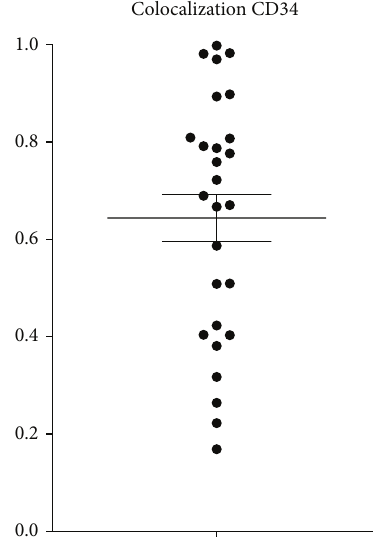
Figure 2: The rate of colocalization with Gremlin in CD34-positive vessels ranged from 0.169 to 0.998 (mean 0.644, SEM 0.049).